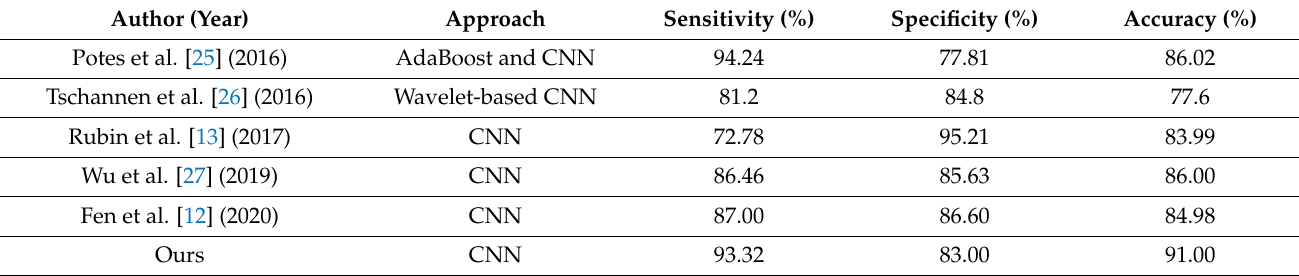
Figure 9. Diagnostic performance. w/o: without; DG: data generalization; DA: data augmentation. Table 3. Comparative evaluation of CNN